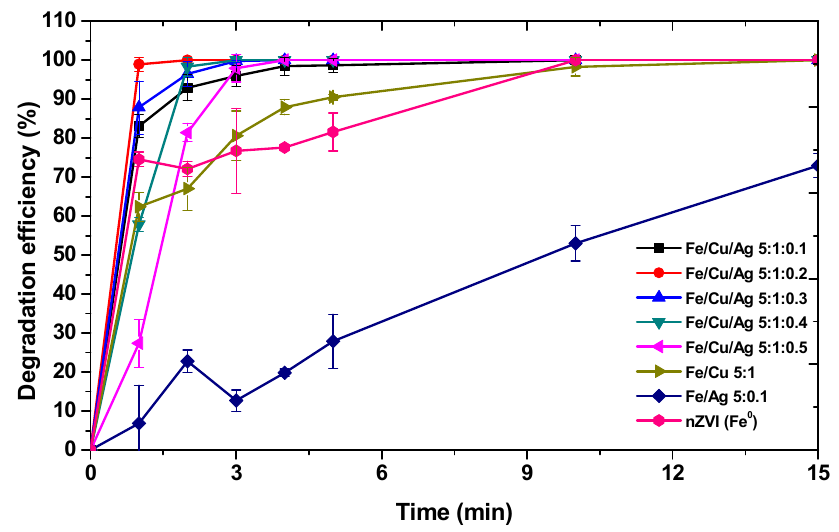
Figure 5. Effect of catalyst composition on MO (pH = ~4.5) degradation efficiency.